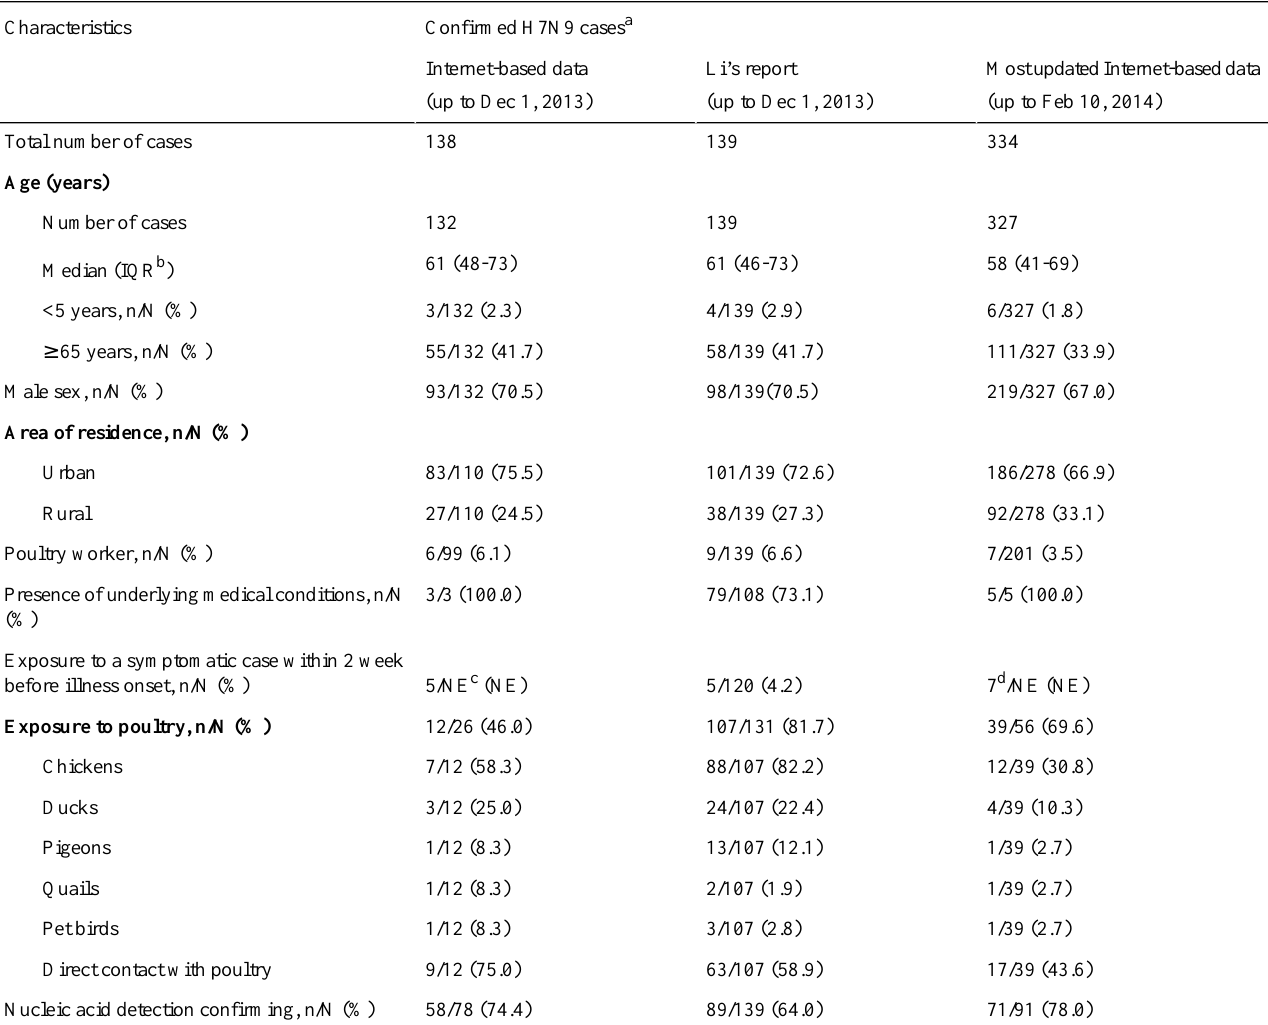
Table 1. Epidemiologic characteristics of patients with confirmed H7N9 infection in China from early 2013 to February 10,